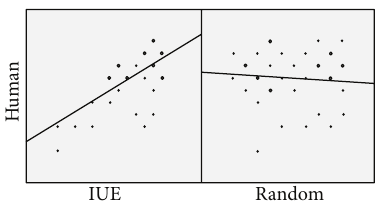
Figure 6: Visualizing the correlation between the IUE tool, random baseline, and human annotators for the task of detecting webpage- to-webpage look-and-feel